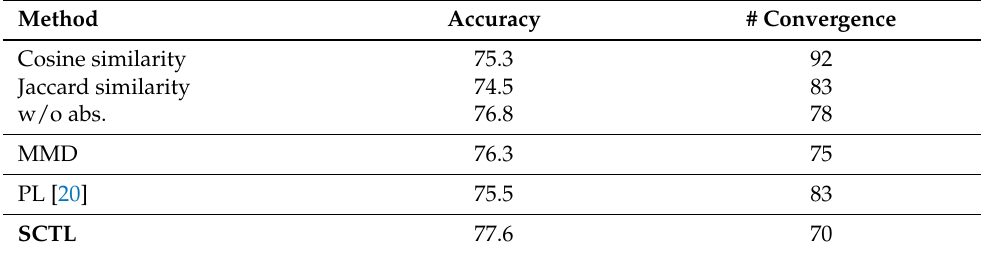
Table 4. Ablation study of L S and L CMMD .